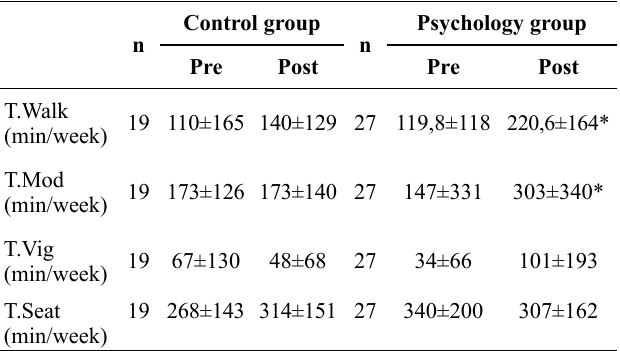
Table 3: Walking time (T.Walk), moderate physical activity time (T.Mod), vigorous physical activity time (T.Vig), Weekend sitting time